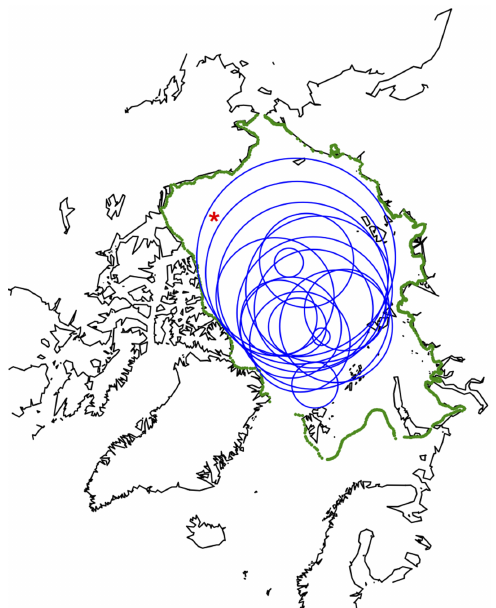
Figure 5. Visualization of one iteration out of 2000 of the Monte Carlo experiments. The area of interest within the Arctic is defined by the green outline. Blue circles represent ODE air masses. The red star represents the average location of the O-Buoy between O- Buoys1 and 2. Seventeen different-sized air masses were randomly placed simultaneously within the area of